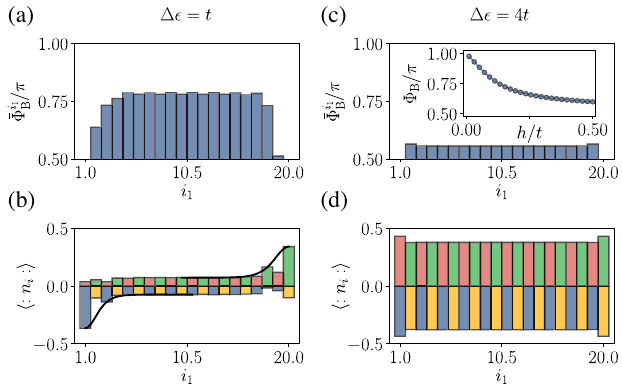
¯ Φ i 1 FIG. 3. Gauge-matter edge states. (a) Average Ising flux in B the ground state of the Creutz-Ising ladder for Δ ¼ t and 20 filled with N ¼ 20 h ¼ 0 . 1 t , for a ladder of length N s ¼ particles. Because of the quantum fluctuations, the bulk flux gets ¯ Φ bulk < π . (b) Fermionic occupation h ∶ n i ∶ i showing lowered, B boundary peaks that can be identified with the topologically protected edge modes. We use red and green to represent odd and even sites, respectively, of the lower leg, and blue and yellow for the upper one. The solid black lines are obtained by fitting the latter to Eq. (13), showing that the excess and defect of the charge are due to the presence of edge states at zero energy. In panels (c) and (d), we can observe how, for a higher value of the imbalance ( Δ ¼ 4 t ), the edge states disappear. The inset shows the flux in an infinite ladder as a function of h=t for Δ ¼ 0 . 1 t